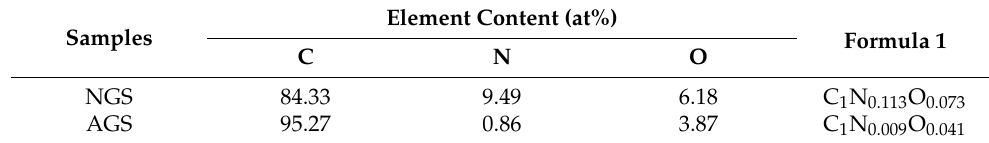
Table 1. The chemical composition of NGS based on XPS